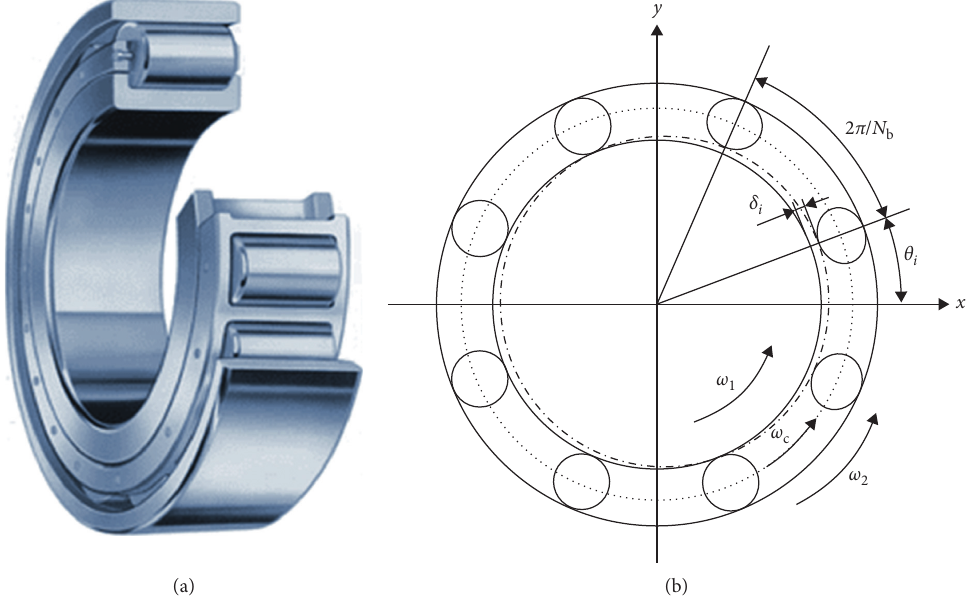
Figure 2: Schematic diagram of the intershaft bearing. (a) Structure of the bearing and (b) sketch in radial